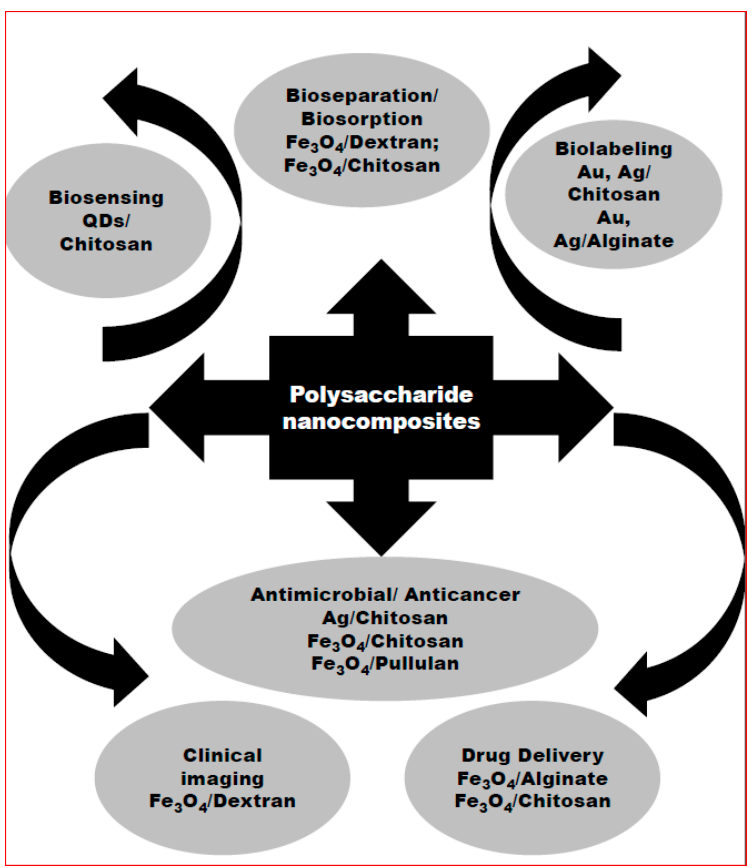
Figure 1. Overview of current scenario of polysaccharide nanocomposite applications. Table 2. List of microbial biogenic polysaccharides used as bionanocomposites.